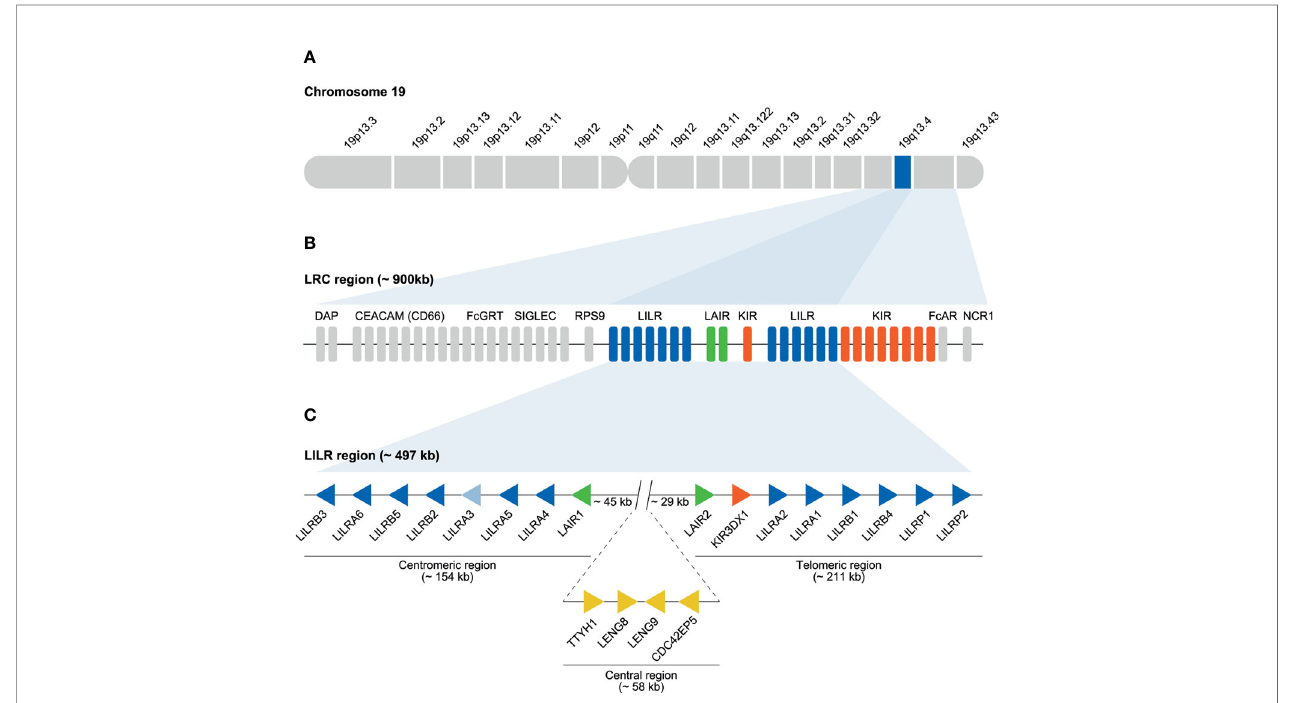
FIGURE 1 | Human LRC region and genomic organization of the LILR gene family. (A) The LRC region located on chromosome 19q13.4. (B) LILR (blue bars), KIR (red bars), and LAIR (green bars) gene families located within the LRC. The remaining genes located in the LRC are indicated by grey bars. (C) The LILR region (~ 497 kb), schematic illustration of the division of the 11 functional LILR genes on the centromeric (~154 kb) and telomeric side of the region (~211 kb) as well as the pseudogenes LILRP1 and LILRP2 located on the telomeric side. LILRA3 is light blue to indicate the null haplotype observed in humans. The regions are separated by a central region of approximately 58 kb that includes the genes TTYH1 , LENG8 , LENG9 , and CDC42EP5 . Between the centromeric and central region, and the central and telomeric region, a stretch of 45 and 29 kb, respectively, is observed. Representing different genes, the arrows are aligned in such a way that they point in the direction of